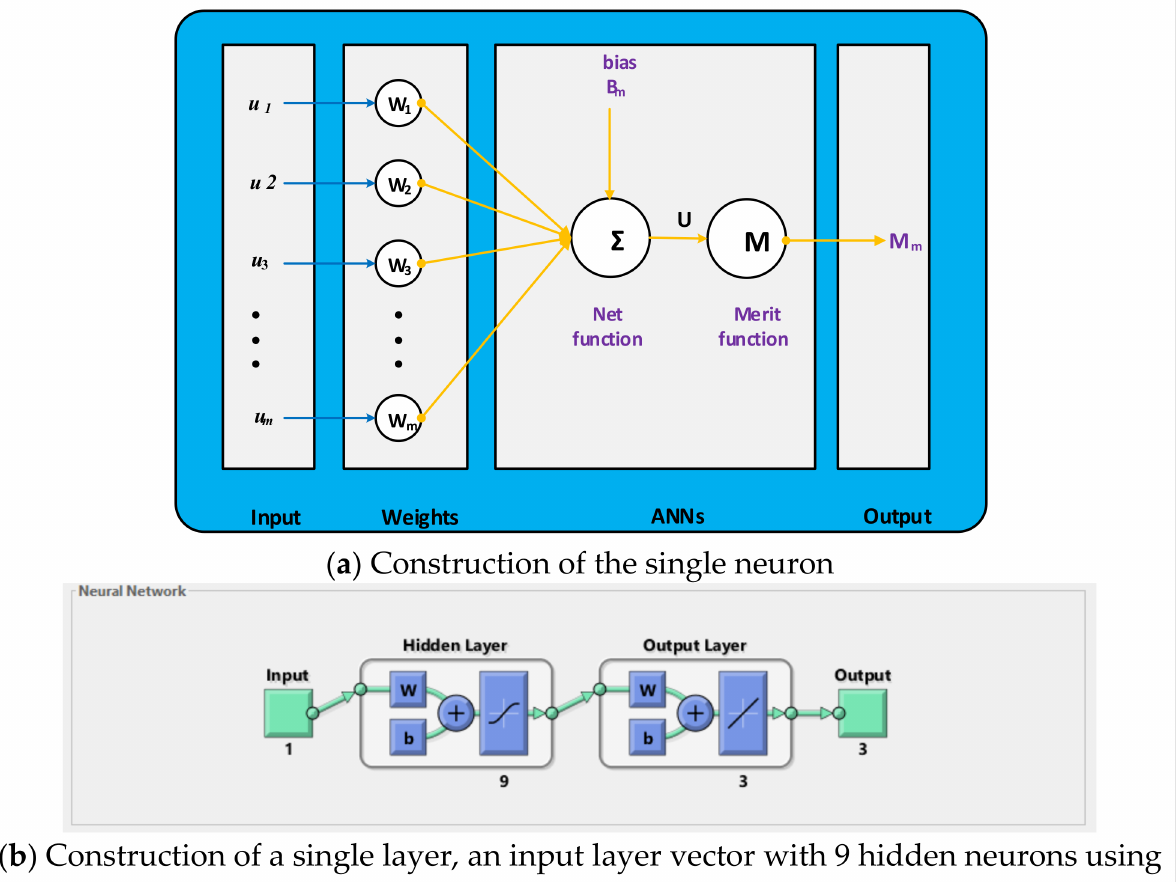
Figure 2. A generic form along with the construction of a single neuron for the dynamical